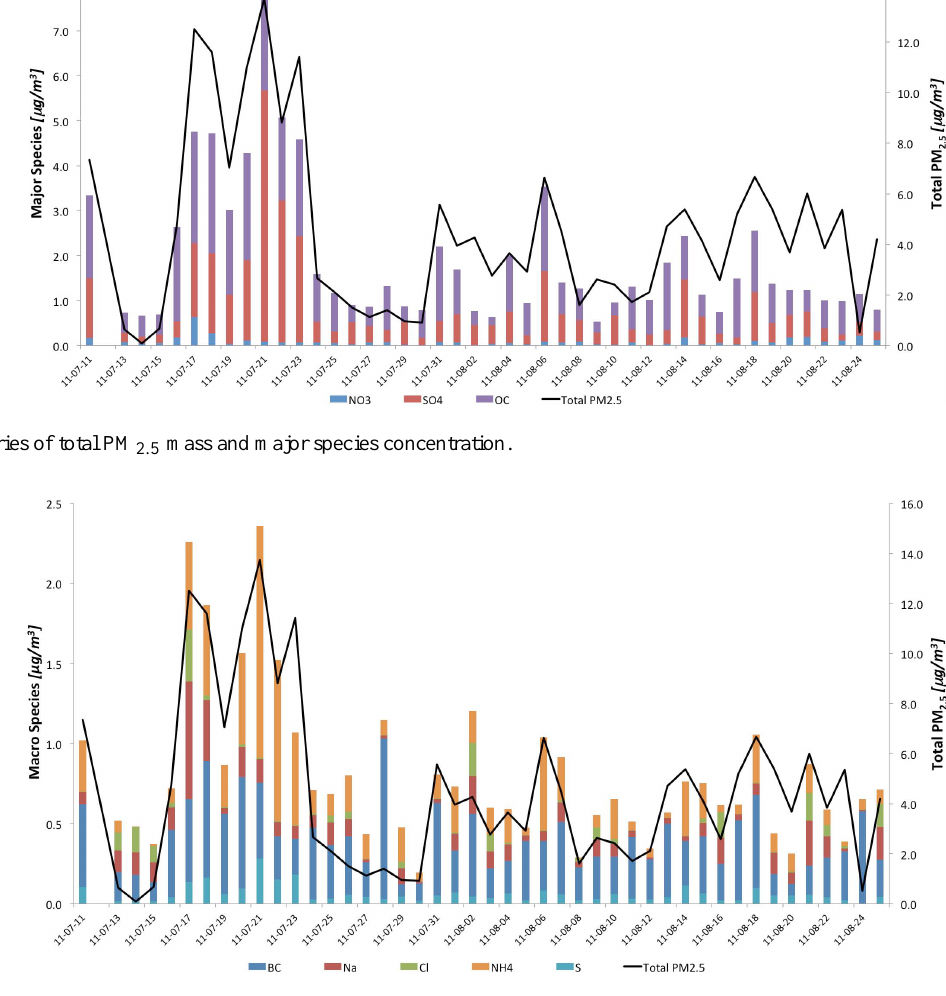
Fig. 5. Time series of total PM 2 . 5 mass and macro species